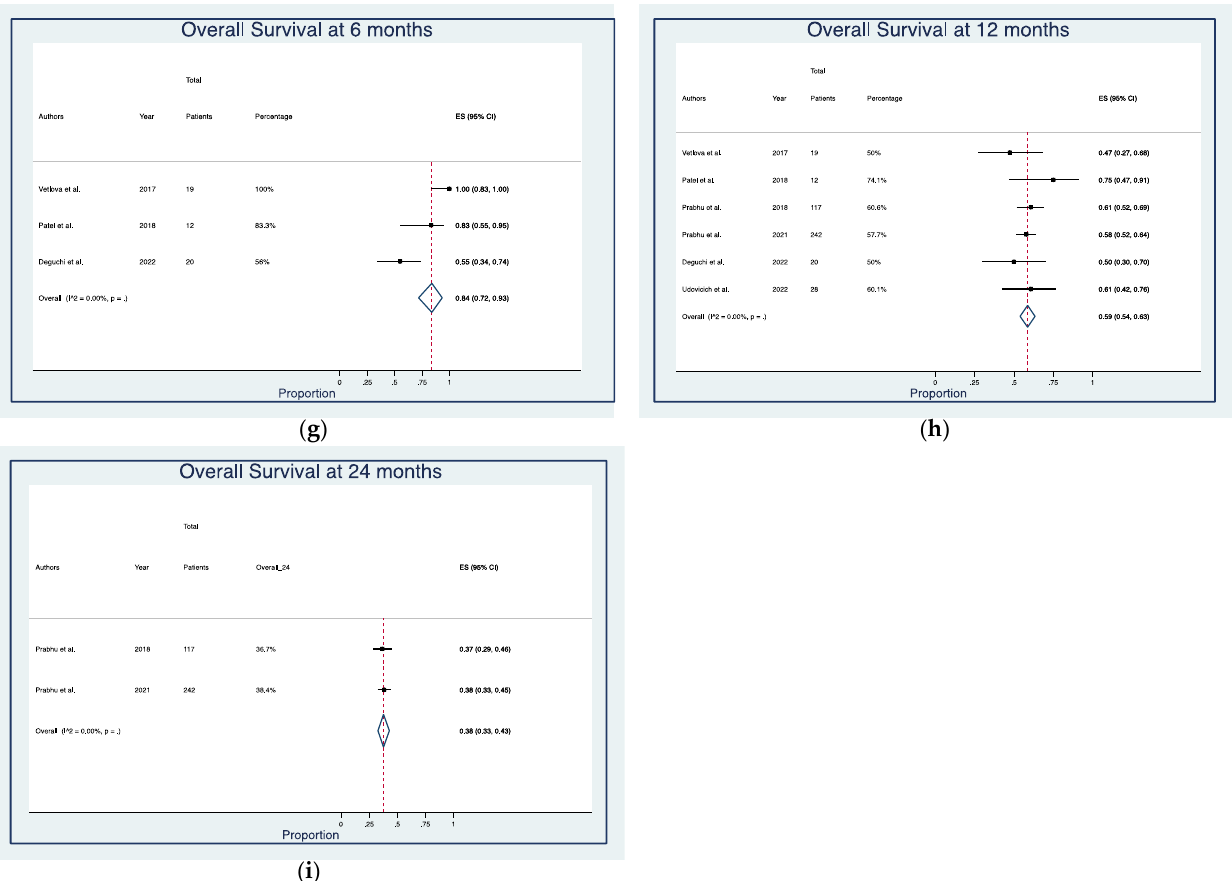
Figure 2. Forest plots of rates of ( a ) radiation necrosis [21,25,26,28,29,31], ( b ) symptomatic radiation necrosis [21,25,26,28,29,31], ( c ) local recurrences [25–31], ( d ) distant brain recurrences [26–29,31], ( e ) leptomeningeal metastases [25–29,31], ( f ) local control at 12 months [25,27,30,31], and overall survival at ( g ) 6 months [25,26,29], ( h ) 12 months [25–29,31], and ( i ) 24 months [27,28]. Squares define the proportions (effect size, ES) of individual studies and horizontal lines mark the 95% confidence intervals (CI). Diamonds indicate the pooled ES with 95% CI using the random effect model meta-analyses.